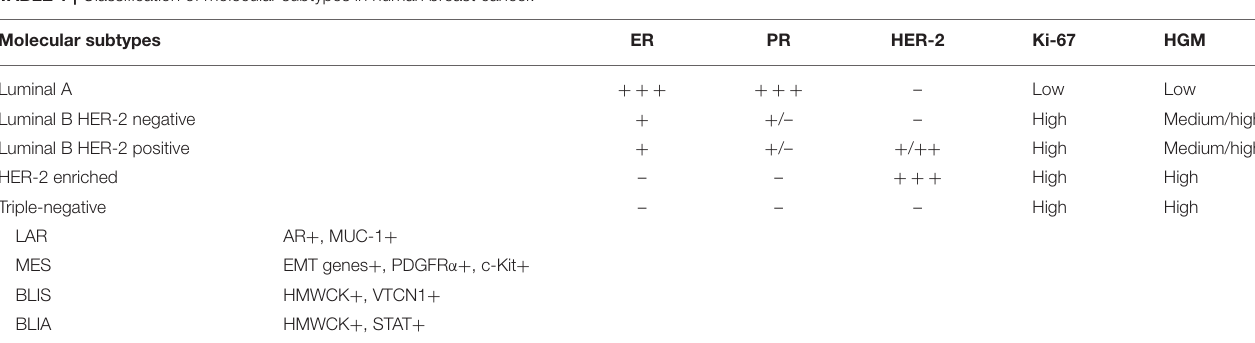
TABLE 1 | Classification of molecular subtypes in human breast